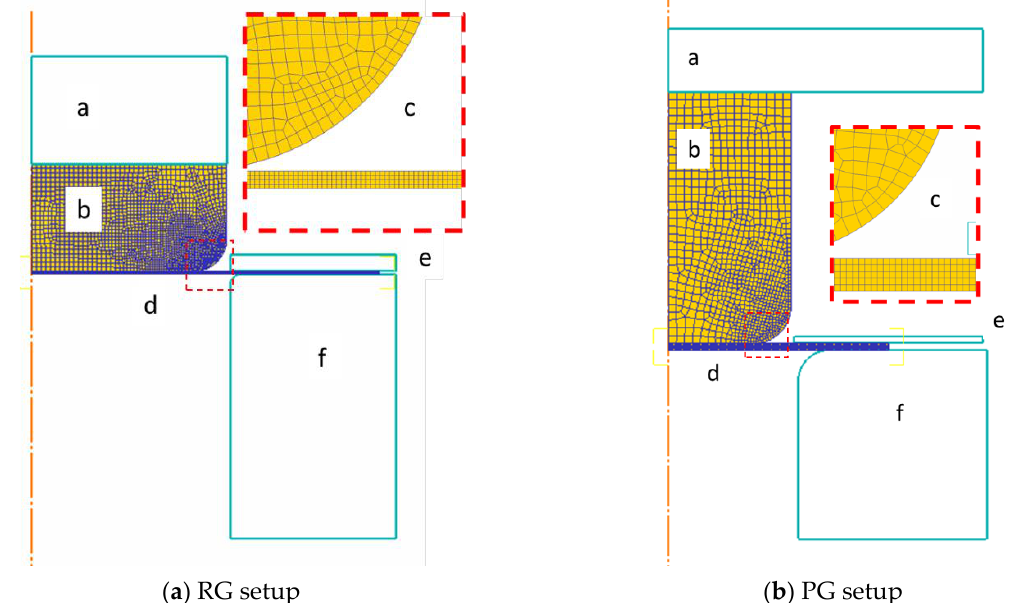
Figure 3. Setup of elements modelled for deep drawing simulations: (a) press; (b) punch; (c) punch with higher mesh magnification on the fillet radii; (d) blank; (e) blankholder; (f) matrix.